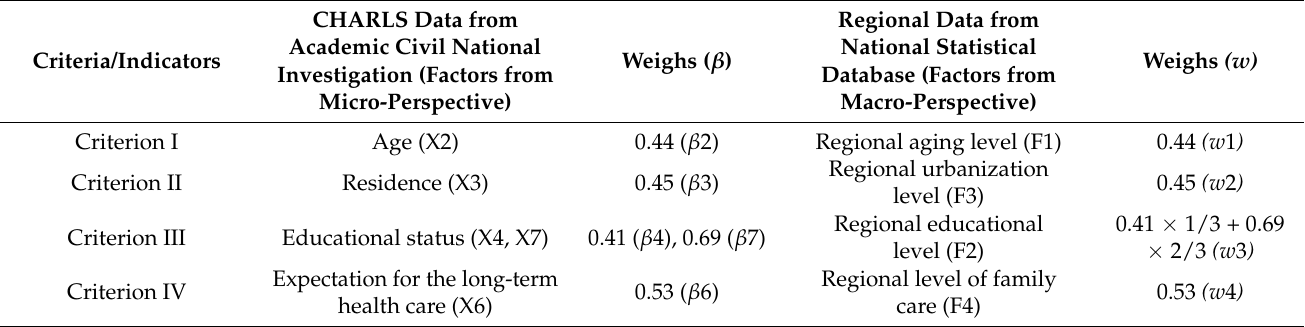
Table 6. The relationship between macro and micro